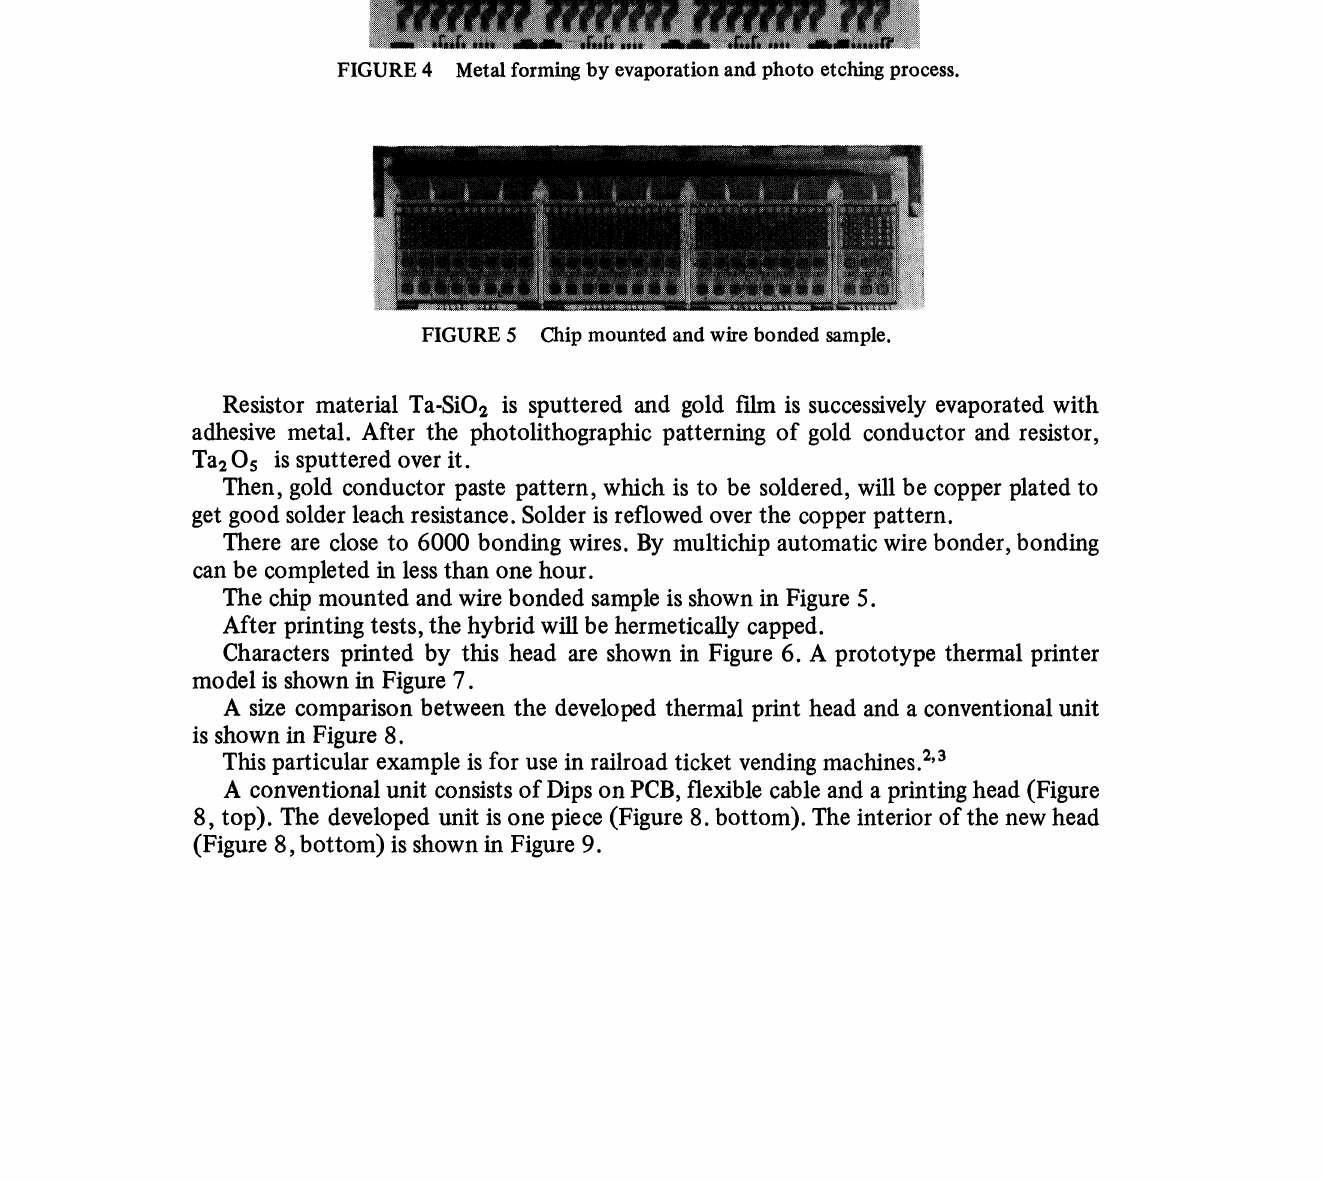
FIGURE 4 Metal forming by evaporation and photo etching process.